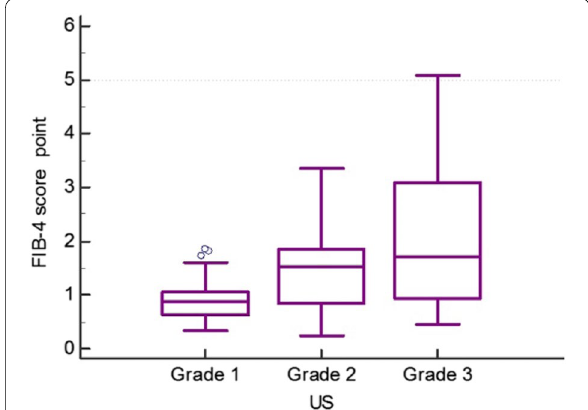
Fig. 1 Box plot showing the median and IQR of FIB-4 score according to the grade of fatty liver by ultrasound among the patients’ group